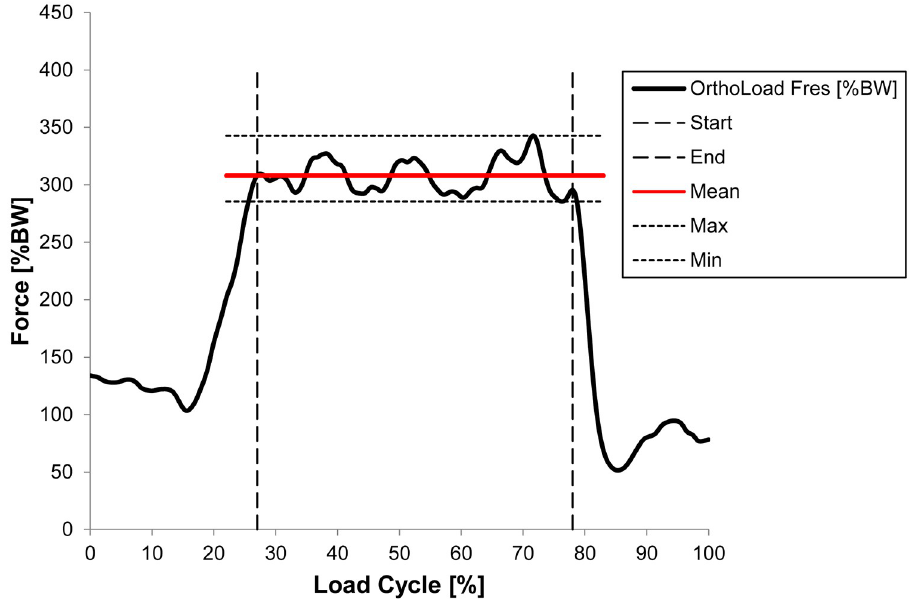
Fig 4. Exemplarily calculation of the average in vivo force in a one-leg stance.